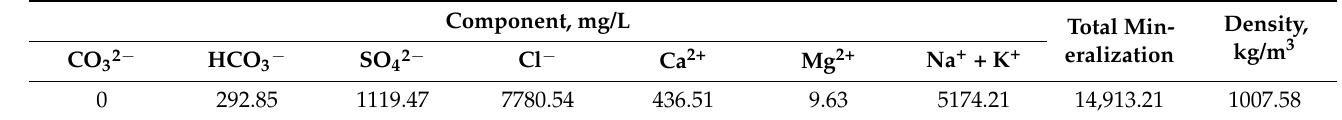
Table 5. Component composition of produced water.